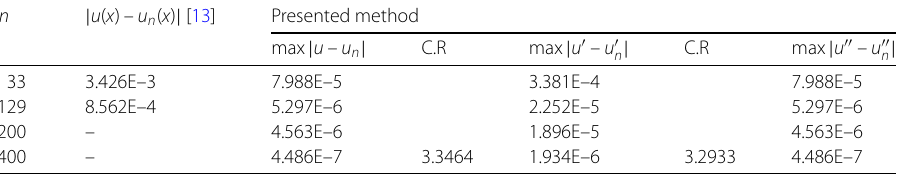
Table 1 Comparison of absolute errors in Example 1